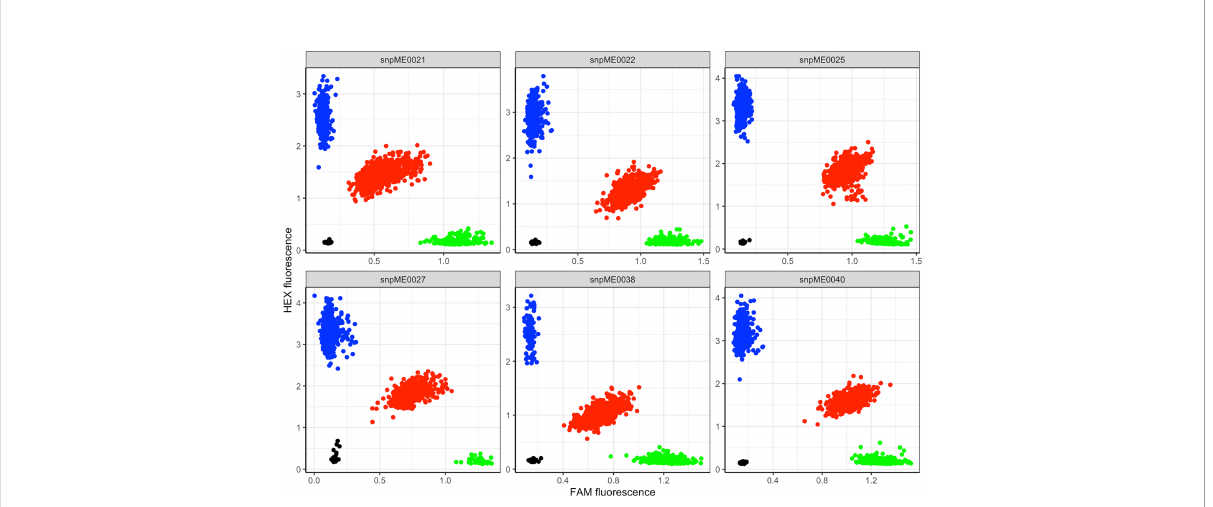
FIGURE 2 Scatter plot for selected KASP assays showing clustering of genotypes on the Y - and X- axes. Genotypes colored blue have a HEX-type allele; genotypes colored green have a FAM-type allele; genotypes colored red are heterozygotes; black dots represent non-template controls.